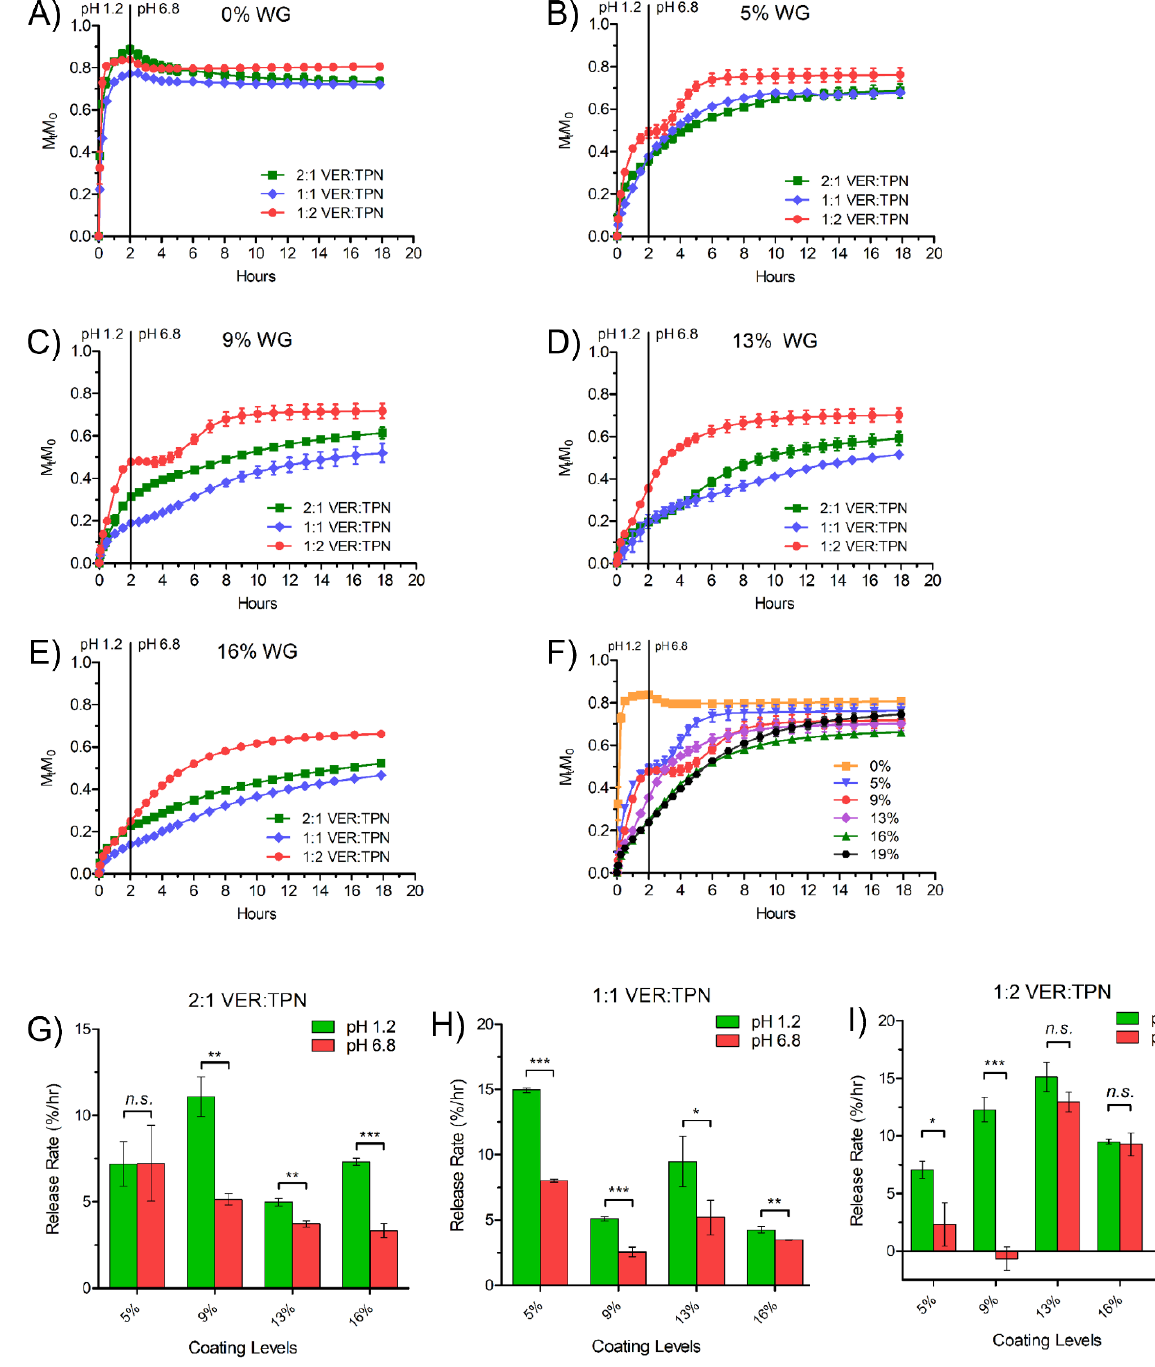
Figure 7. Dissolution profiles showing the effect of VER:TPN ratio in VER-TPN-EC matrix layer and TPN-EC membrane coating level. ( A ) 0%, ( B ) 5%, ( C ) 9%, ( D ) 13%, ( E ) 16% weight gain, and ( F ) 0% to 19% weight gain at 1:2 VER:TPN ratio, and comparison of VER release rates surrounding the pH transition at pH 1.2 (1 – 2 h) and pH 6.8 (2 – 3 h) between bilayer-coated bead formulations. ( G ) 2:1 VER:TPN, ( H ) 1:1 VER:TPN, and ( I ) 1:2 VER:TPN at various membrane coating levels. Data are mean ± SD. n.s. , not significant, * p ≤ 0.05, ** p ≤ 0.01, and *** p ≤ 0.001.